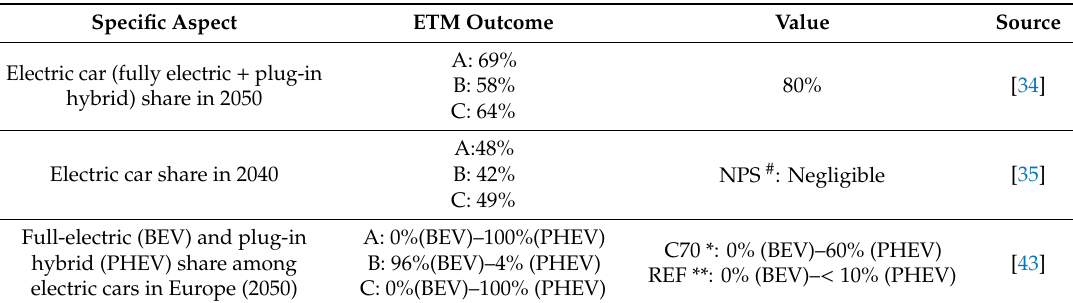
Table 13. Cars: ETM vs. other model